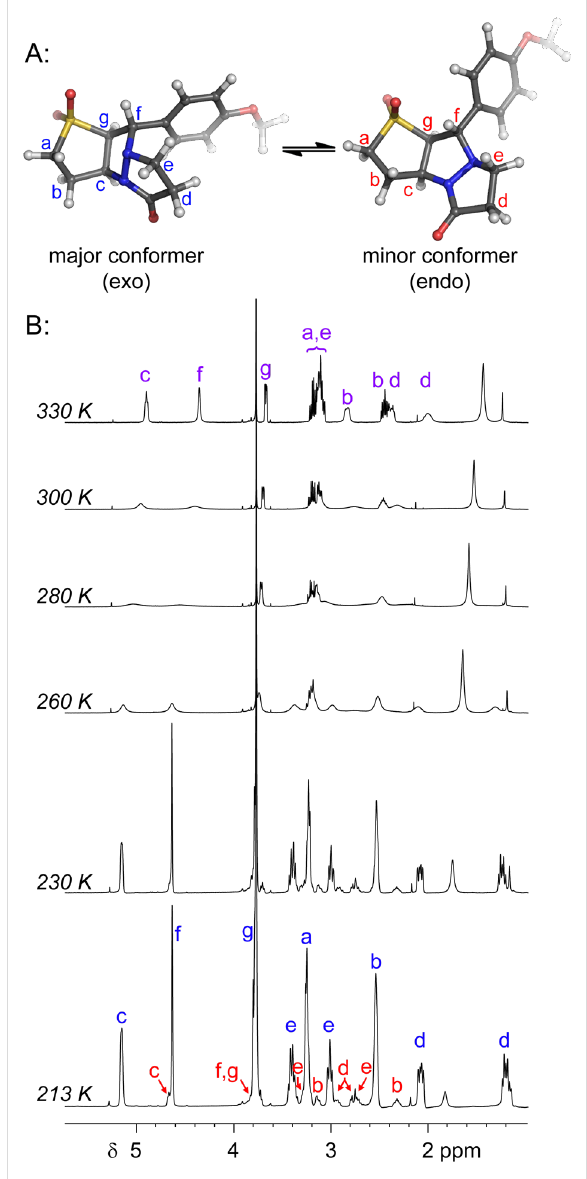
Figure 2: Assignment of major and minor conformations of 3a ; A: DFT-calculated conformers; B: Collected 1 H NMR spectra at various temperatures, in CDCl 3 . Assignments in Figure 2B refer to the structures in Figure 2A, where blue = major isomer, red = minor isomer and purple = equilibrating